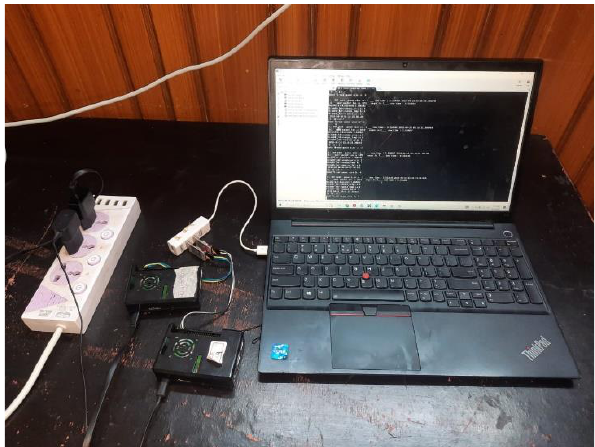
Figure 4. Practical implementation at sink node.